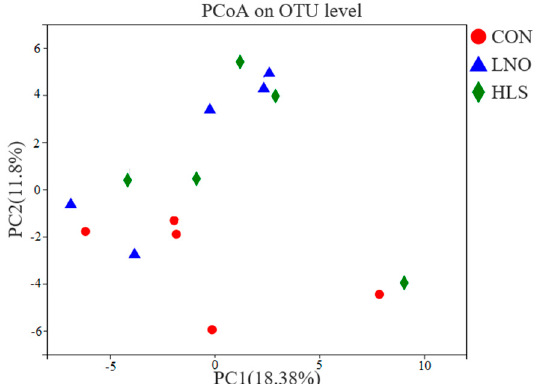
Figure 2. Principal coordinate analysis (PCoA) (using the weighted Unifrac similarity metric) of bacterial operational taxonomic units (OTUs) in the ileum digesta of goat kids. Each symbol represents one treatment: The solid red circle represents kids fed the basal diet (CON), the solid blue triangle represents kids fed the basal diet supplemented with flaxseed oil (LNO), and the solid green rhombus represents kids fed the basal diet supplemented with heated flaxseed grain (HLS). A total of 698 OTUs were obtained from all samples, of which 402 exist in all groups defined as core OTUs (Figure 3). The core OTUs comprised approximately 57.6% of the total OTUs. In addition, 25, 38, and 54 OTUs were uniquely identified in groups CON, LNO, and HLS, respectively.